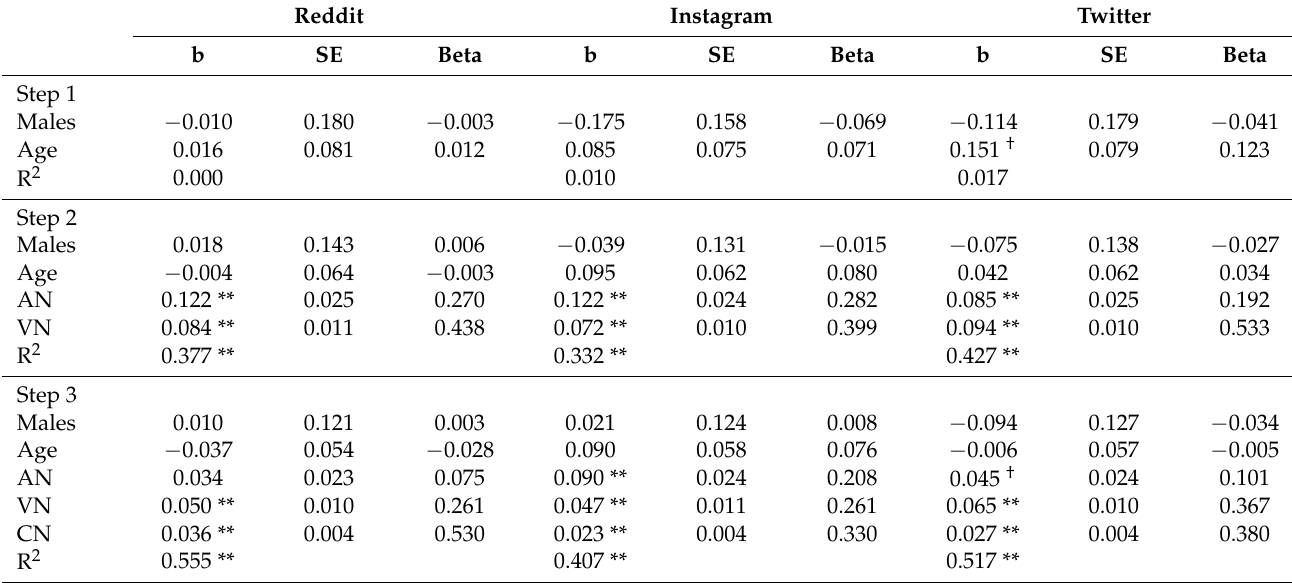
Table 5. Multiple linear regression predicting feedback/validation of social media for Reddit, Instagram and Twitter, showing unstandardized coefficients (b), standard errors (SE) and standardized coefficients